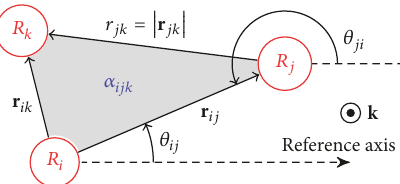
Figure 2: Configuration of 3 agents showing distance 𝑟 𝑗𝑘 between the relative position vectors, orientation angle 𝜃 𝑖𝑗 , and the shaded oriented area 𝛼 𝑖𝑗𝑘